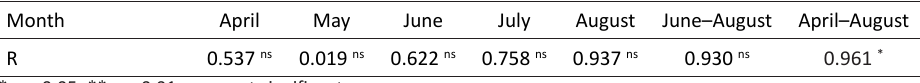
Table 5. Pearson’s correlation coefficients (r) for total rainfall in different months, for the entire vegetation period and seed yield white lupin